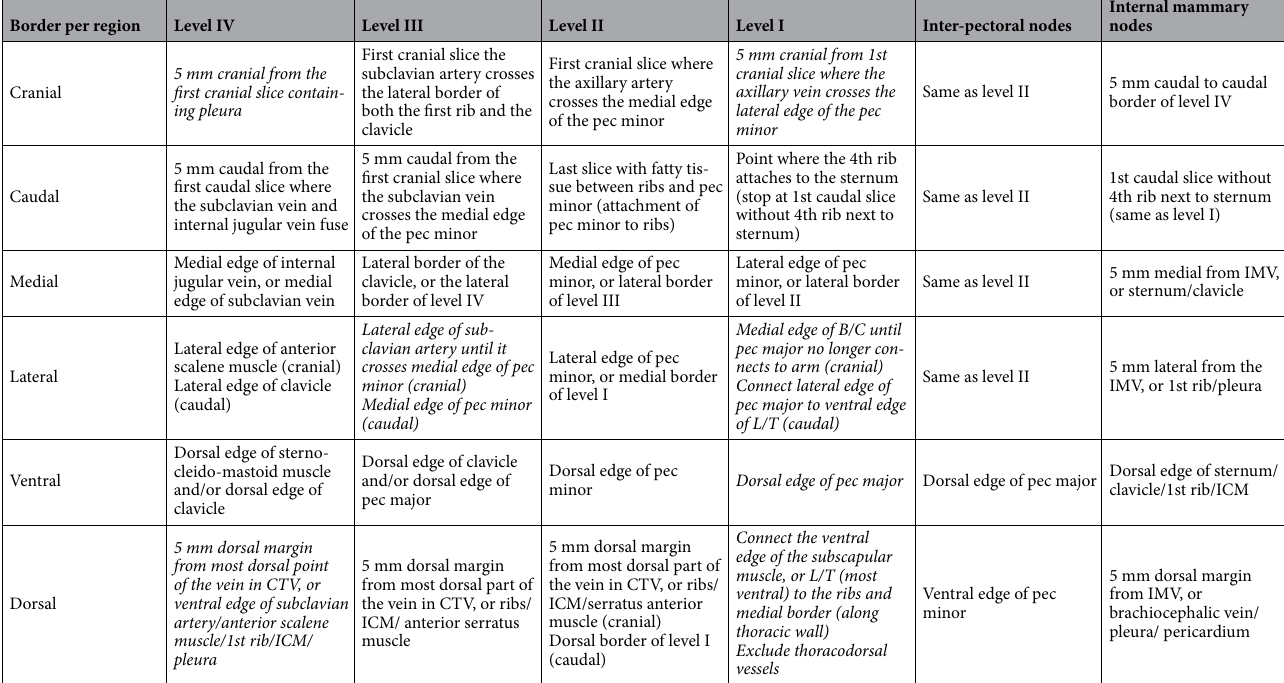
Table 1. Prone crawl position specific delineation guidelines for the CTV of the lymph node regions. Borders that had to be changed from the ESTRO (and PROCAB) guideline are written in italics. B/C